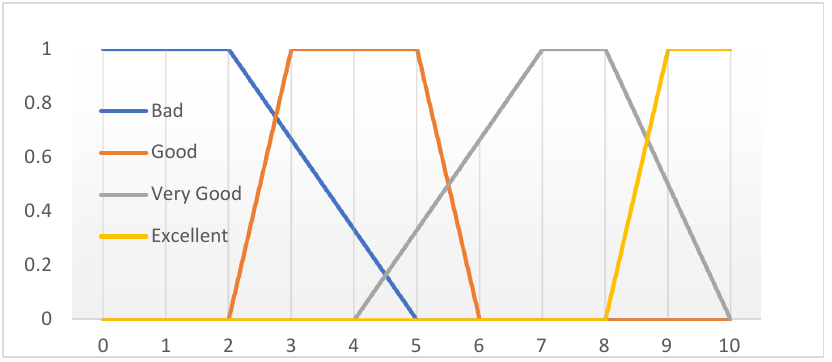
Fig. 1 . Function of contribution of the criterion experience in years